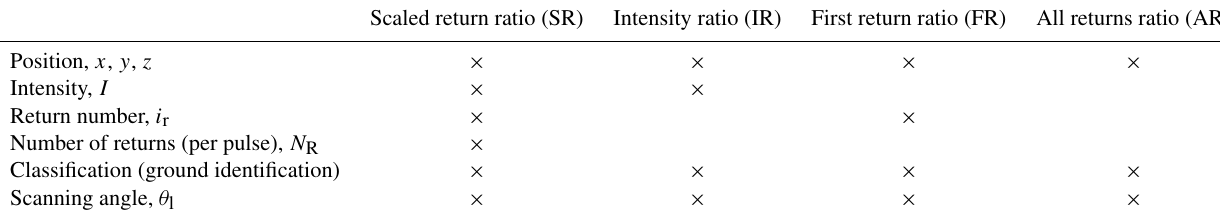
Table 1. Attributes used to calculate the PAD from ALSs with four different methods. The attributes are usually available with data in the .las